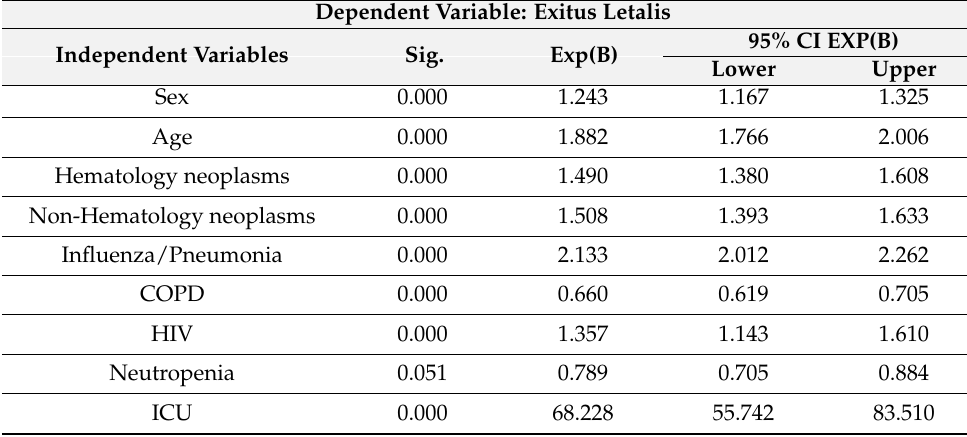
Table 3. Multivariate Logistic Regression